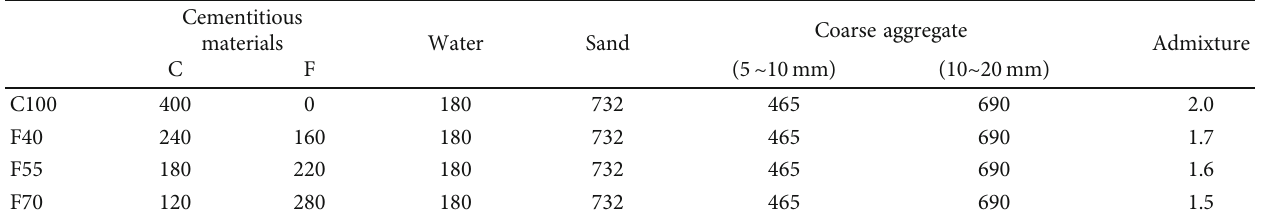
Table 2: The proportions of the mixtures in the C30 concrete (0.45 water-cement ratio).